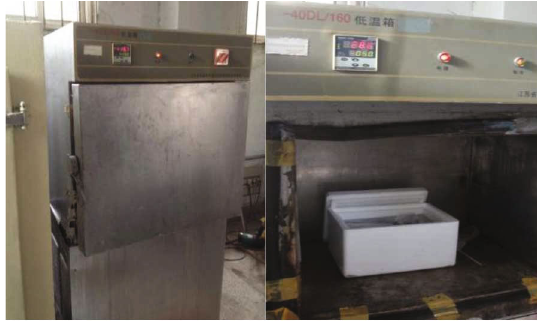
Figure 2: Freeze-thaw